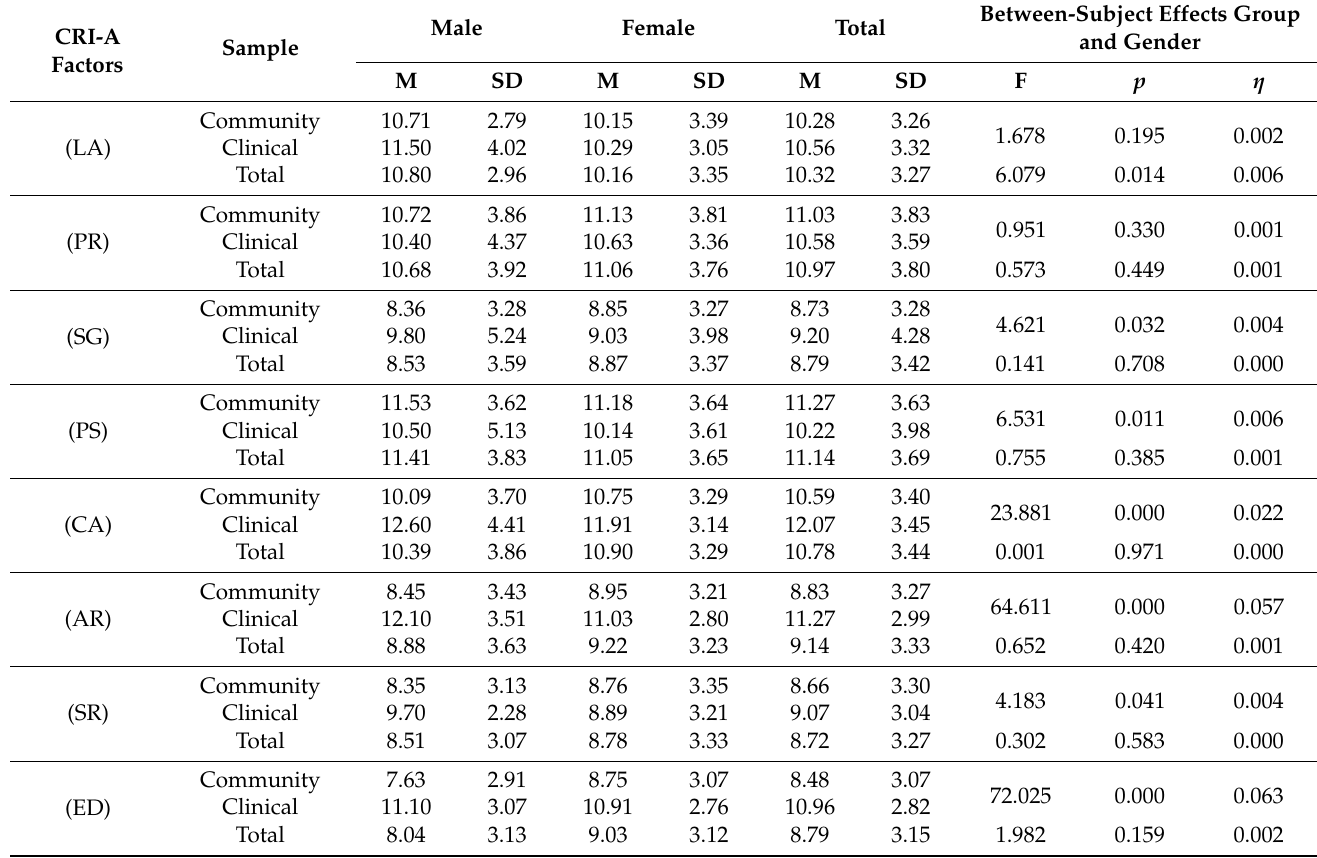
Table 2. Descriptive analysis for the eight CRI-A factors and univariate analysis by group (community/clinical) and gender. CRI-A